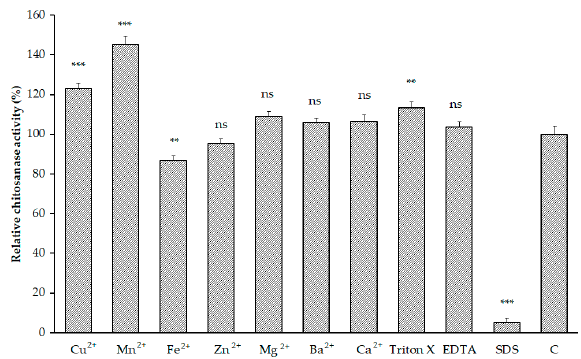
Figure 4. Effects of some chemicals on the activity of Paenibacillus sp. TKU047 chitosanase. All data points were the mean and standard deviation. Note: ns, **, *** were not significantly different, or significantly different at p < 0.01, or p < 0.001 (respectively). The activity of the enzyme incubated with the buffer was used as the control group.